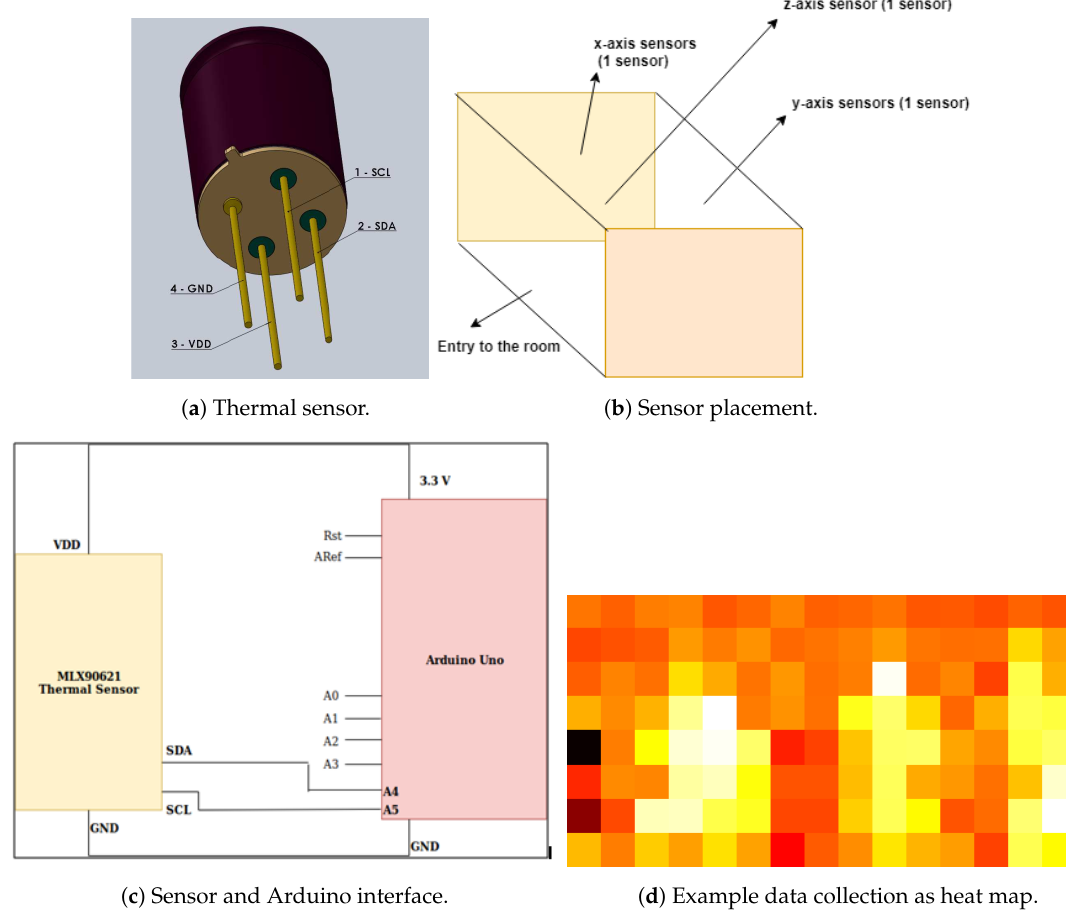
Figure 1. Hardware setup and data